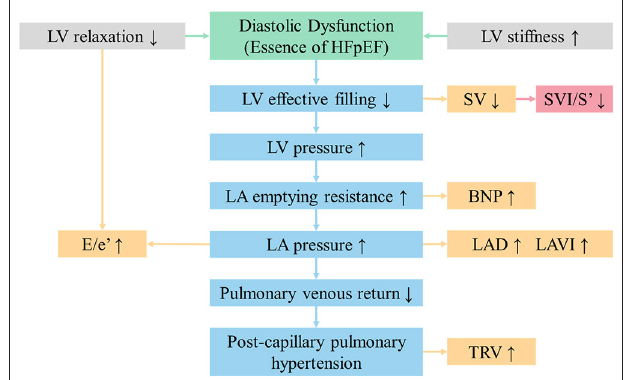
FIGURE 4 | SVI/S’ is the initial changing echocardiographic parameter in the process of HFpEF. BNP, brain natriuretic peptide; E/e’, the ratio of early diastolic transmitral velocity to early diastolic septal myocardial velocity; HFpEF, heart failure with preserved ejection fraction; LA, left atrium; LAD, left atrial diameter; LAVI, left atrial volume index; LV, left ventricular; SVI/S’, the ratio of body surface area standardized stroke volume (SVI) and tissue Doppler mitral annulus systolic peak velocity; TRV, tricuspid regurgitation